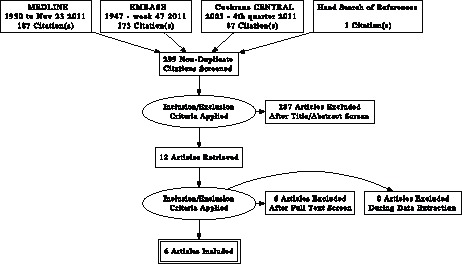
PRISMA Flow diagram.